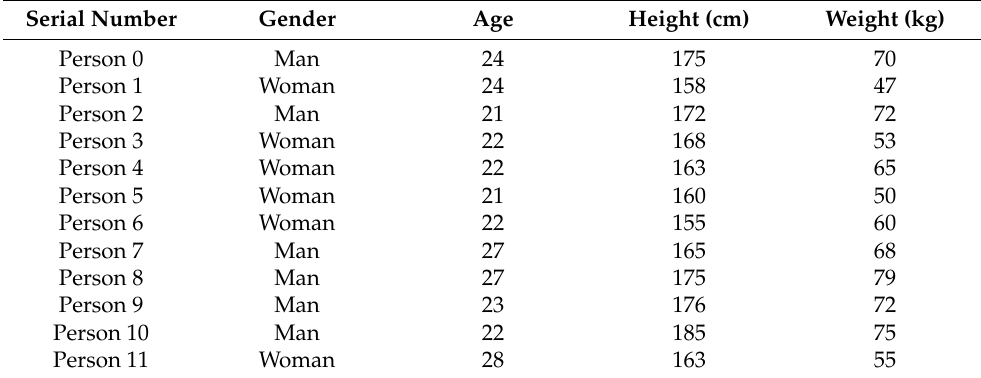
Table 2. Personal attributes of professional table tennis players.